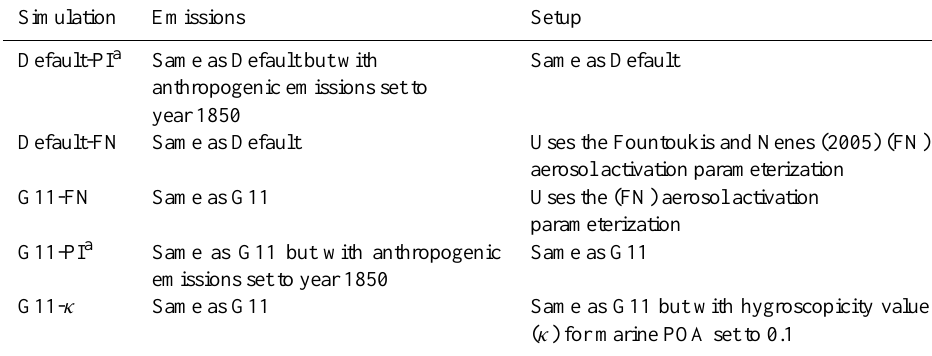
Table 1b. Description of additional CAM5 simulations. Simulation Emissions Setup Same as Default Default-PI a Same as Default but with anthropogenic emissions set to year 1850 Default-FN Same as Default Uses the Fountoukis and Nenes (2005) (FN) aerosol activation parameterization G11-FN Same as G11 Uses the (FN) aerosol activation parameterization G11-PI a Same as G11 but with anthropogenic Same as G11 emissions set to year 1850 G11- κ Same as G11 Same as G11 but with hygroscopicity value ( κ ) for marine POA set to